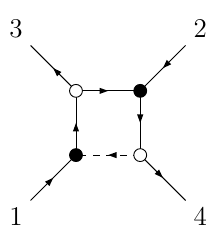
Figure 6 . On-shell diagram for 4-point amplitude with a split helicity arrangement.